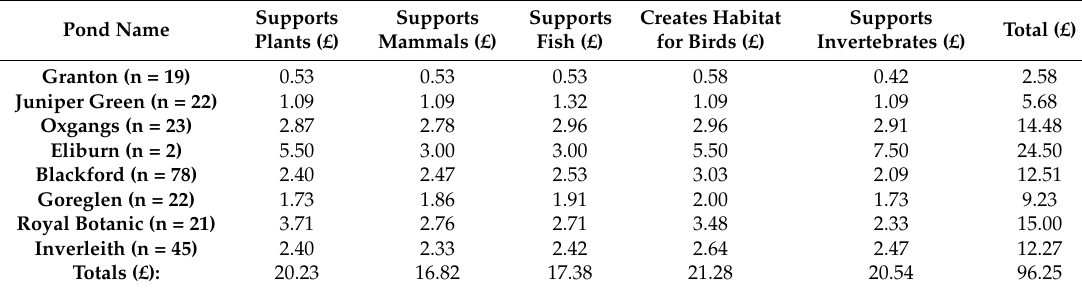
Table 2. Habitat benefits according to the residents in the survey: where the monthly total value is divided by the number living near each pond (SUDS = Granton, Juniper Green, Oxgangs and Eliburn). Total n =